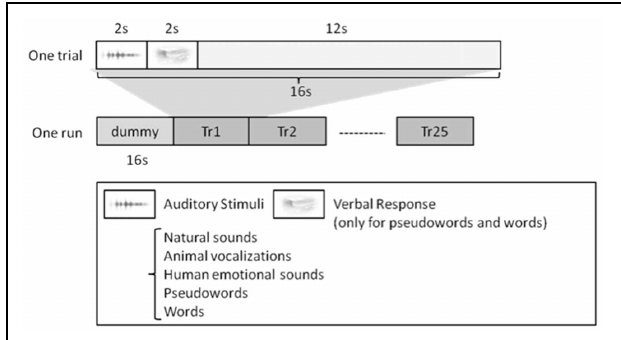
FIGURE 1 | Experiment Design. For speech sounds, i.e., words and pseudowords, the subjects were asked to repeat what they heard. For the other stimuli, i.e., natural sounds, animal vocalizations, and human non-speech sounds, they simply listened to the stimuli. One trial lasted 16s in length, and each run consisted of 25 trials. Each subject had four separate runs.